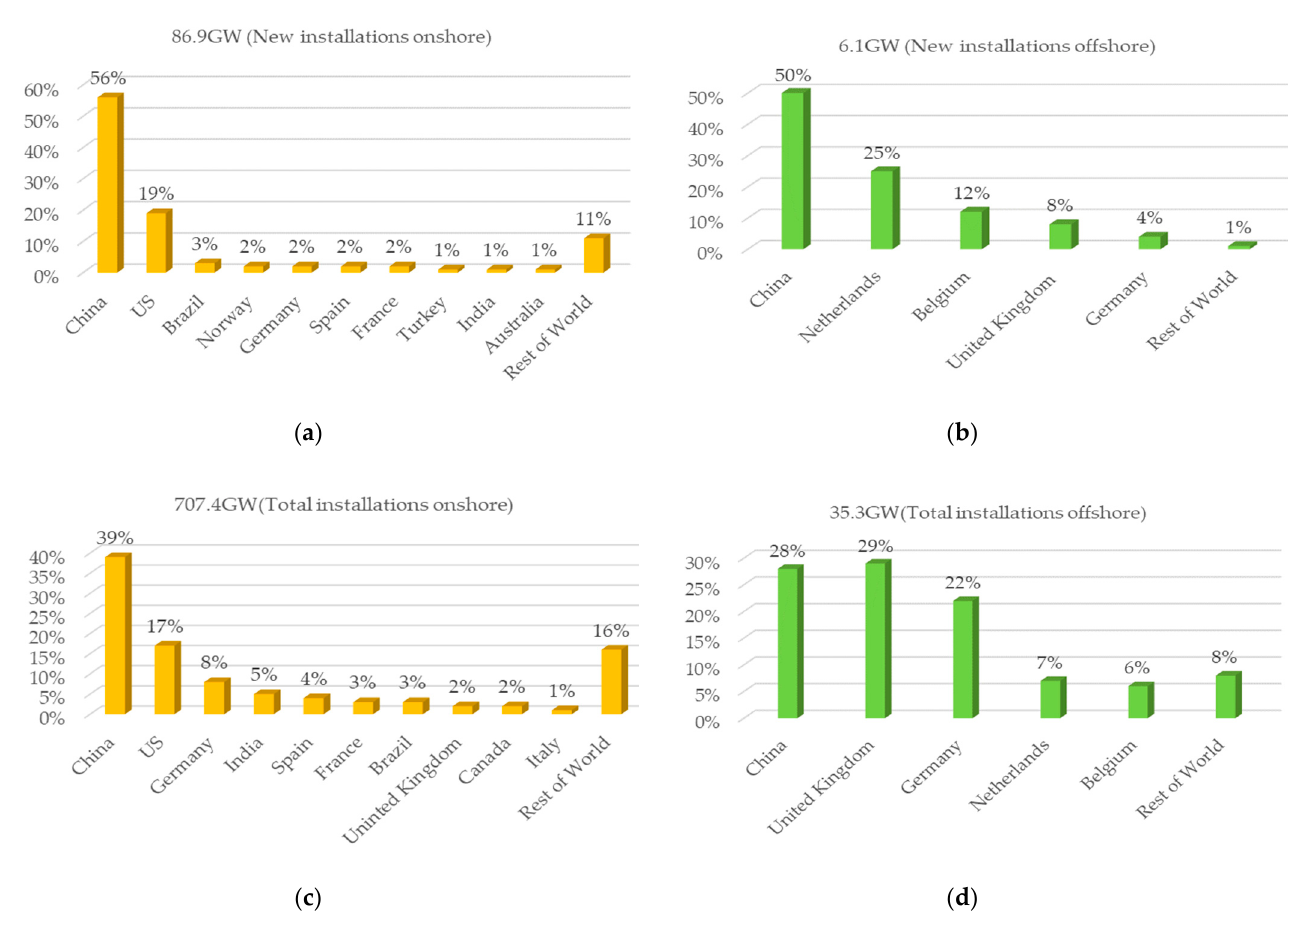
Figure 9. ( a ) New installations onshore (%); ( b ) New installations offshore (%); ( c ) Total installations onshore (%); ( d ) Total installations offshore (%). Source: Global Wind Report 2021. Source: Global Wind Report [36].